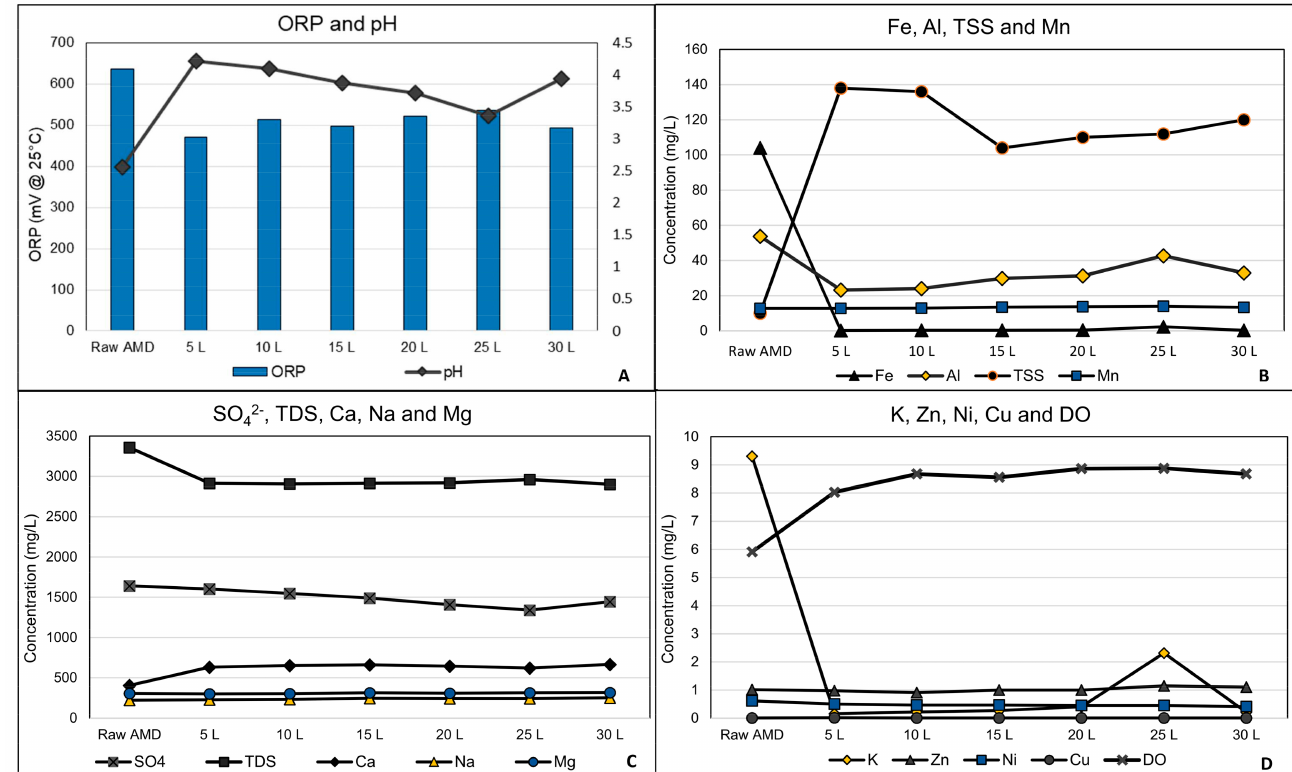
Figure 4. Pre-treatment results: ( A ) results for ORP and pH, ( B ) results for Fe, Al, TSS and Mn, ( C ) results for SO 42 − , TDS, Ca, Na and Mg, ( D ) results for K, Zn, Cu and DO. The pH increased from 2.56 to an average pH of 3.9, the oxygen reduction potential (ORP) reduced from 636.6 mV to an average of 505.6 mV and the dissolved oxygen (DO) concentration was increased from 5.91 mg/L to an average concentration of 8.62